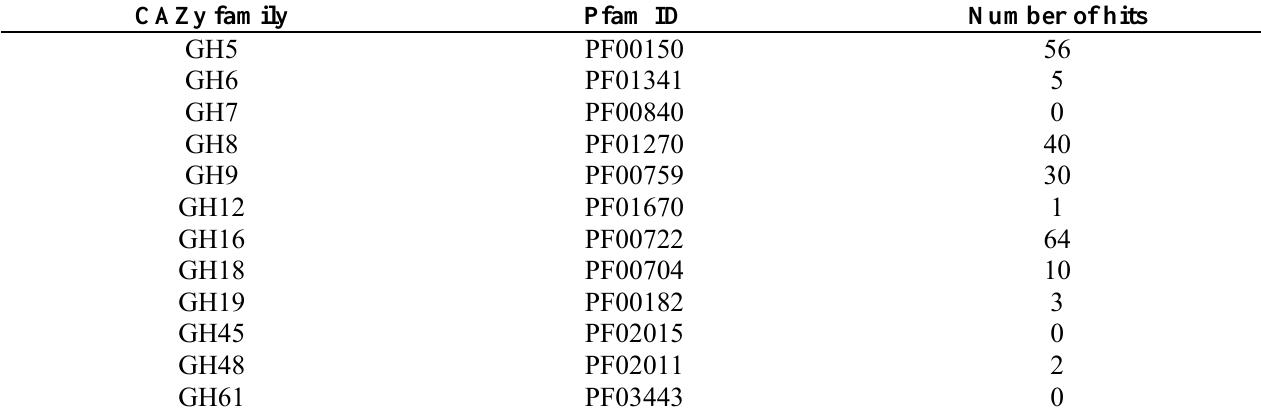
Table 2. Summary of the number of 454 sequencing contigs matching each GH